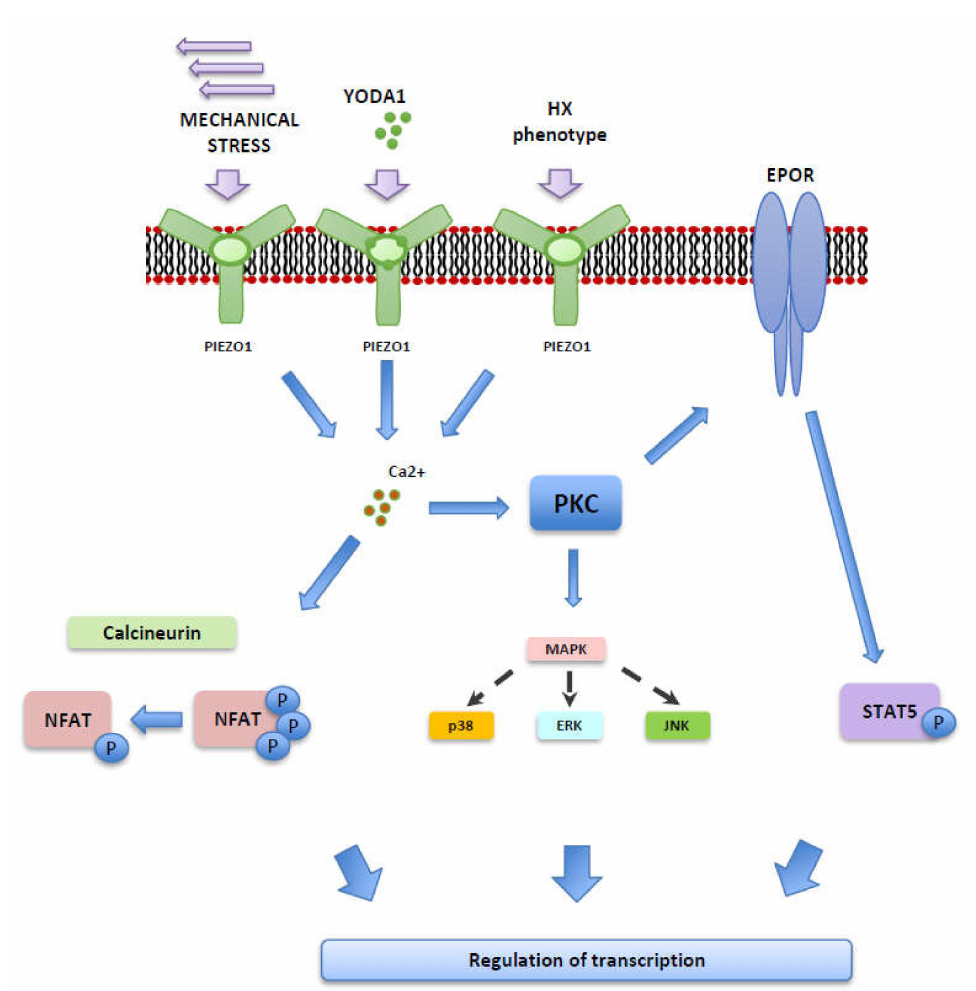
Figure 4. Overview of possible signal transduction downstream of PIEZO1 activation triggered by mechanical stress, upon the PIEZO1 agonist Yoda1 or the HX